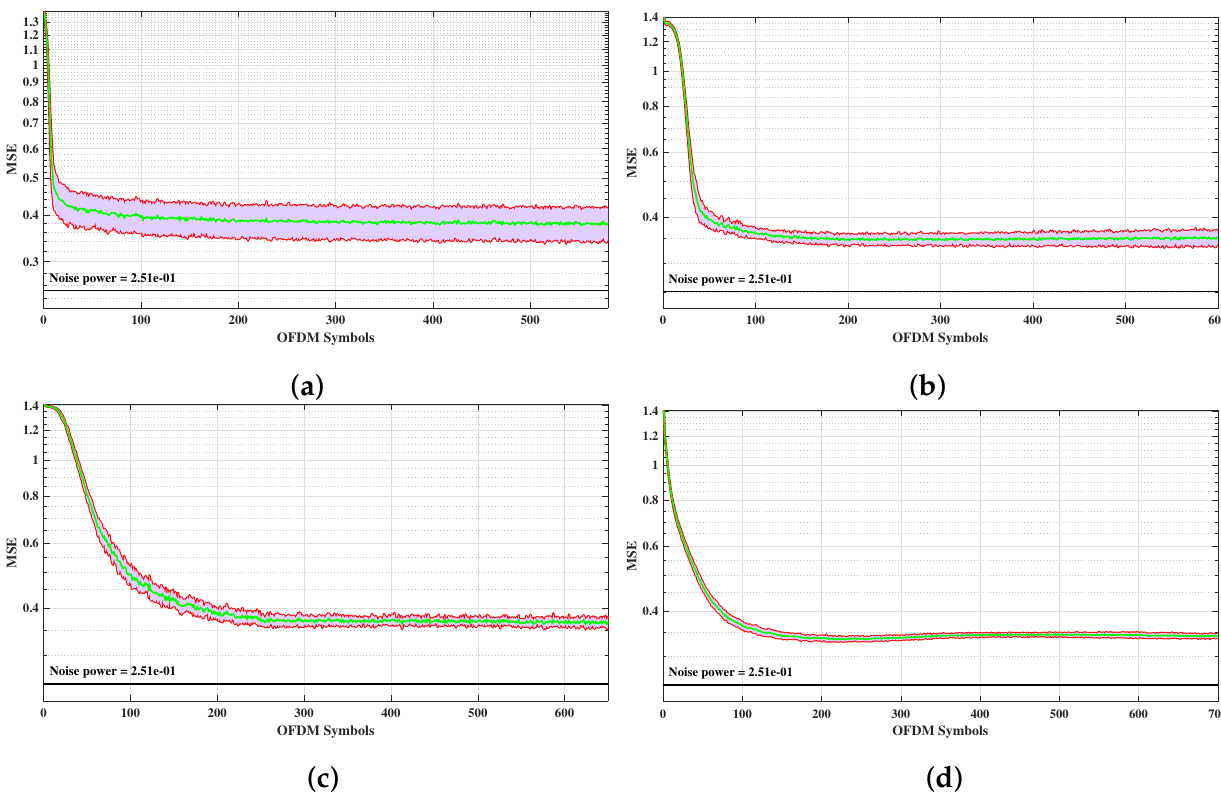
Figure 11. Evolution of MSE values averaged over 10 realization sequences of the proposed MMPTRBF network decoder, using 4-QAM and E b / N 0 = 12 dB for ( a ) M T = M R = 4 antennas, ( b ) M T = M R = 8 antennas, ( c ) M T = M R = 16 antennas, ( d ) M T = M R = 32